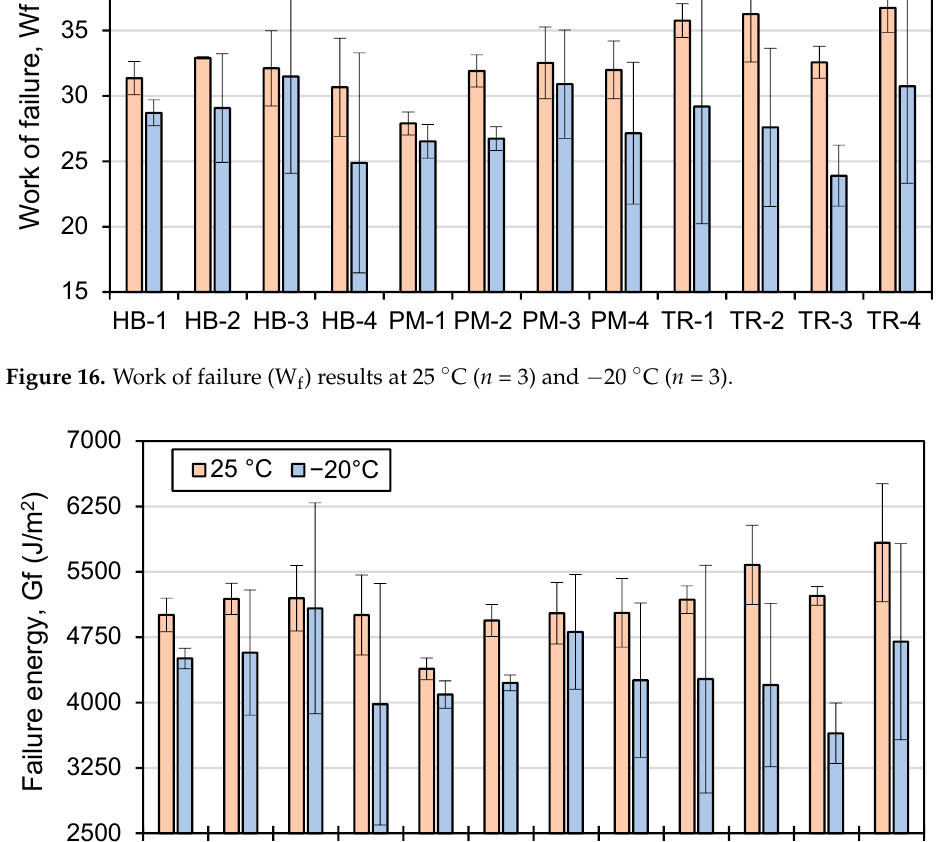
Figure 17. Failure energy (G f ) results at 25 °C ( n = 3) and − 20 °C ( n = 3).